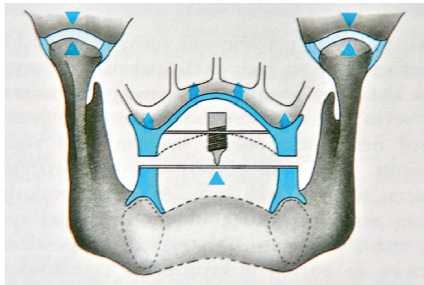
Figure 1: The scheme of gothic arch tracing method.